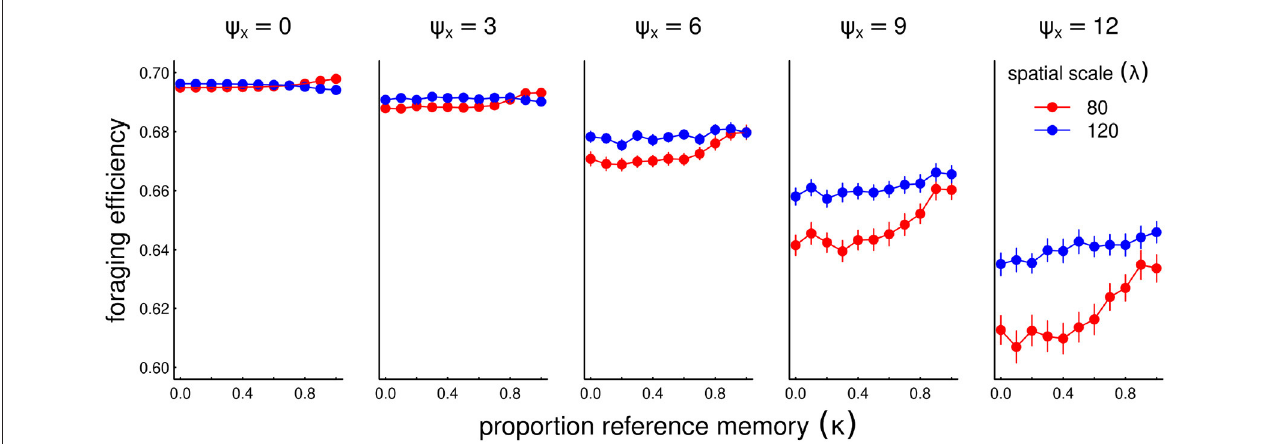
FIGURE 7 | Foraging efficiency (FE) across various values of reference memory κ ( x -axis) for increasing amounts of interannual stochasticity ( ψ x , panels left to right), and two values of sociality spatial scale λ 80 and 120. For the processes with non-zero stochasticity ( ψ x > 0), the process was run 90 times for values of κ . Points = represent the average of the FE’s across all 50 years and 90 replicates. In these scenarios, the resource following parameter α and diffusion ε 4. Note that the y -axis scale is constrained over a relatively narrow range (0.6–0.7). =